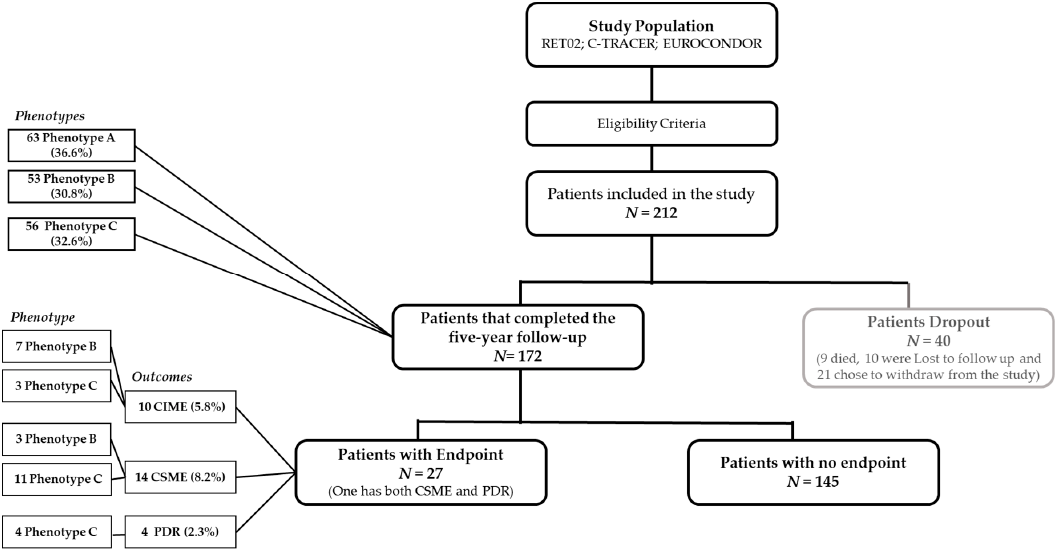
Figure 1. Composition of the patients included in the study over the study period: CONSORT flowchart. CIME: center-involved macular edema; CSME: clinically significant macular edema; PDR: proliferative retinopathy.